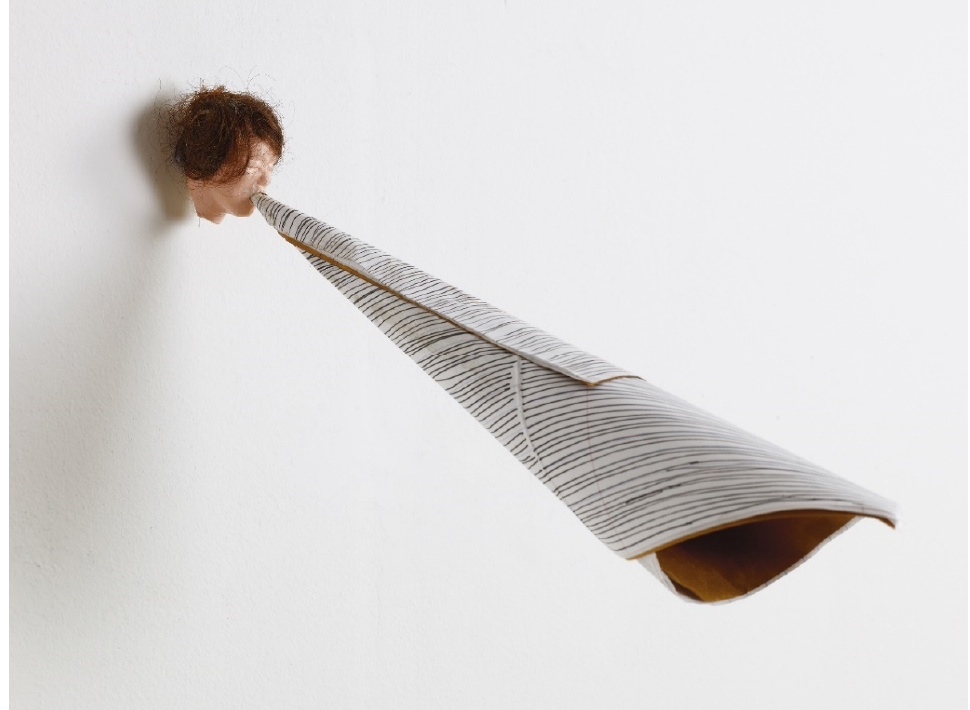
Figure 5. Dvora Morag, “Make a Sound”, 2013. Mixed Media. Photo: Avi Amsalem.